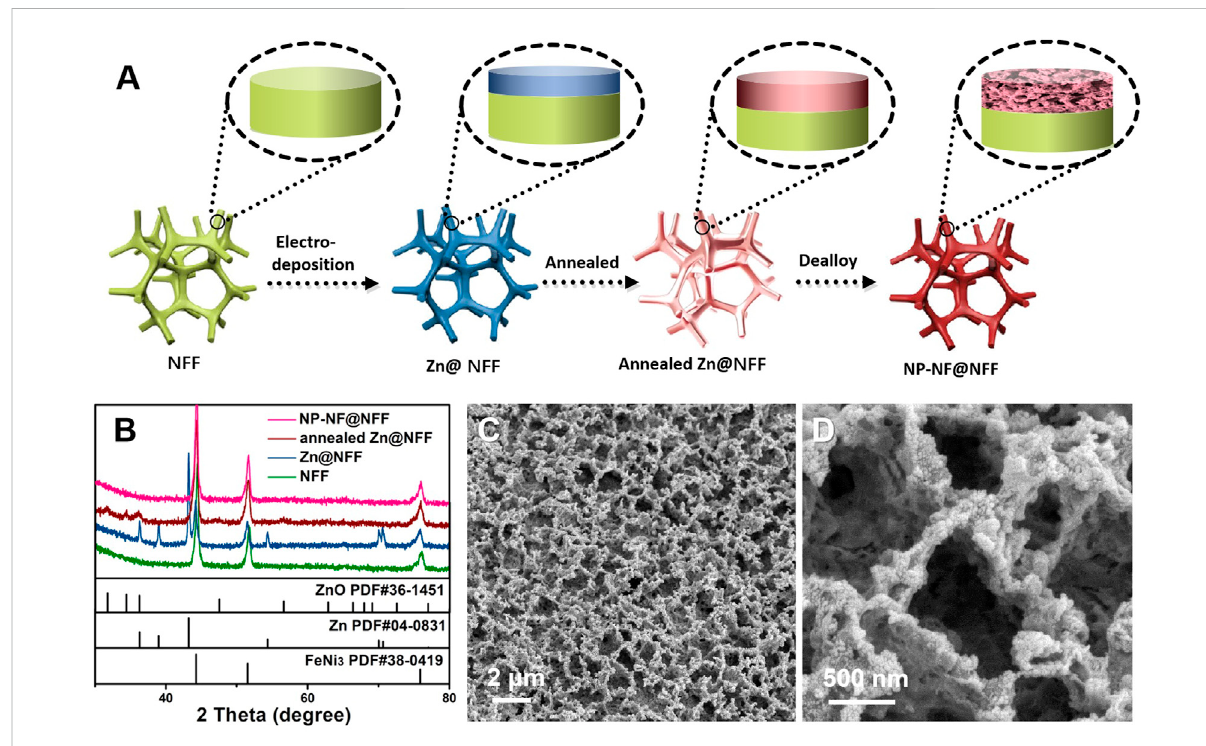
FIGURE 1 (A) Illustrationoftheelectroplating – annealing – dealloyingfabricationprocessofNP-NF@NFF; (B) XRDpatternsofNFF,Zn@NFF,annealedZn@ NFF and NP-NF@NFF; and (C) and (D) SEM images of